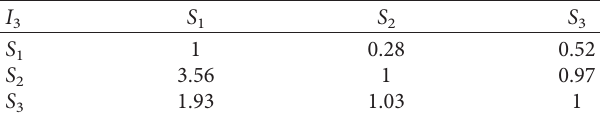
Table 12: Weightage of the indicator NR by AHP on prediction 3 .